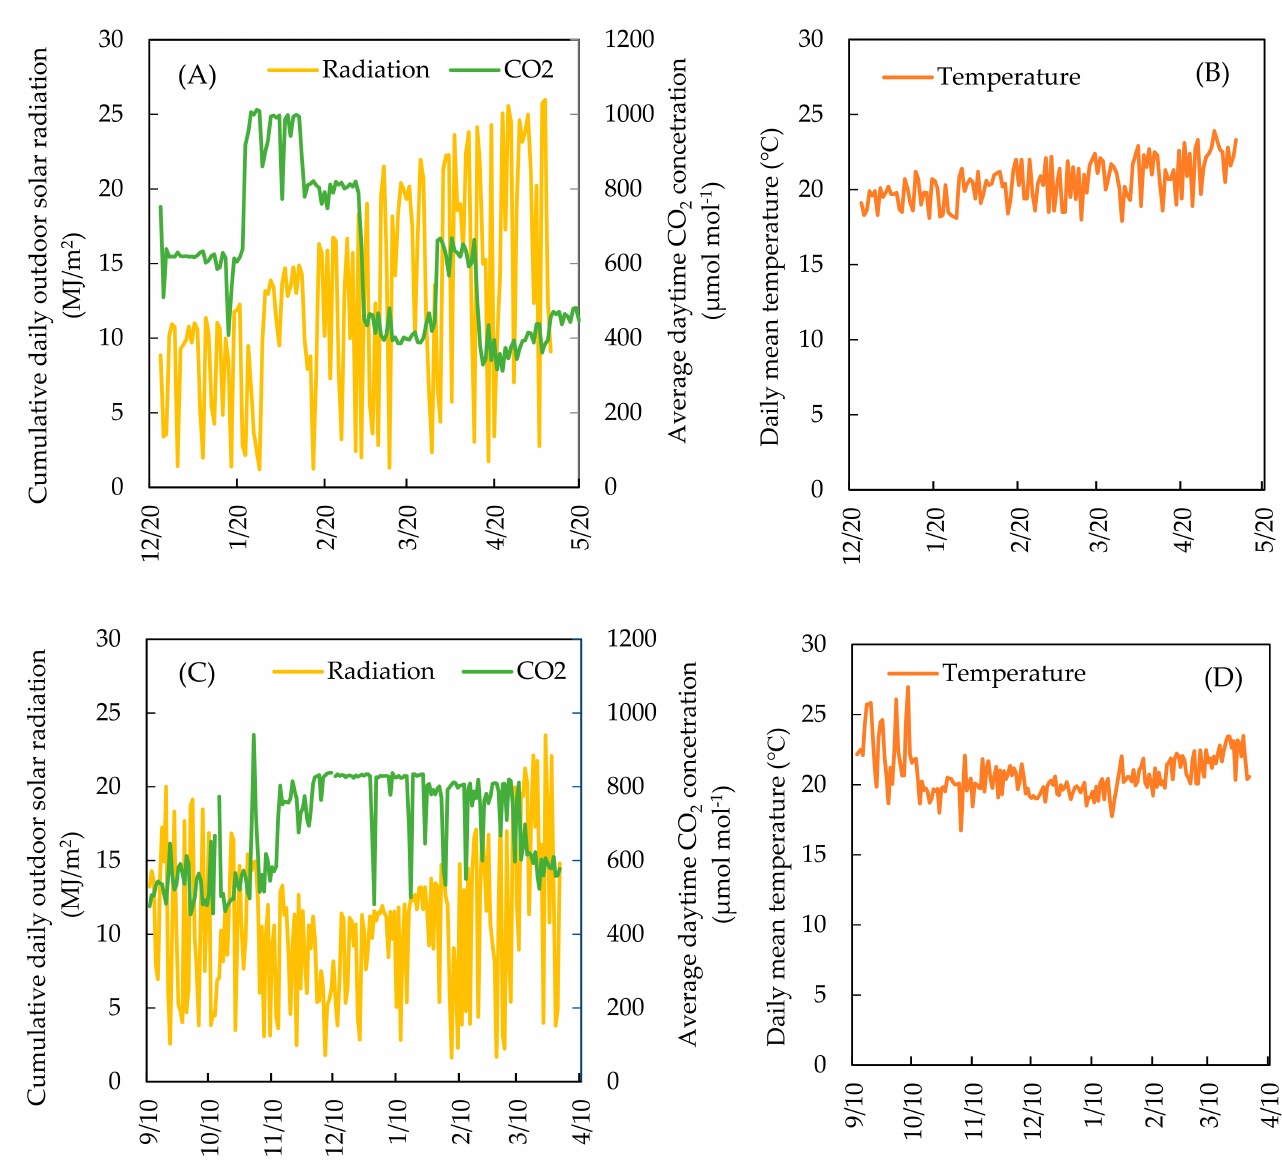
Figure 1. Change in daily mean temperature, cumulative daily outdoor solar radiation and observed daytime CO 2 concentration. ( A , B ) Initial experiments. ( C , D ) Model validation